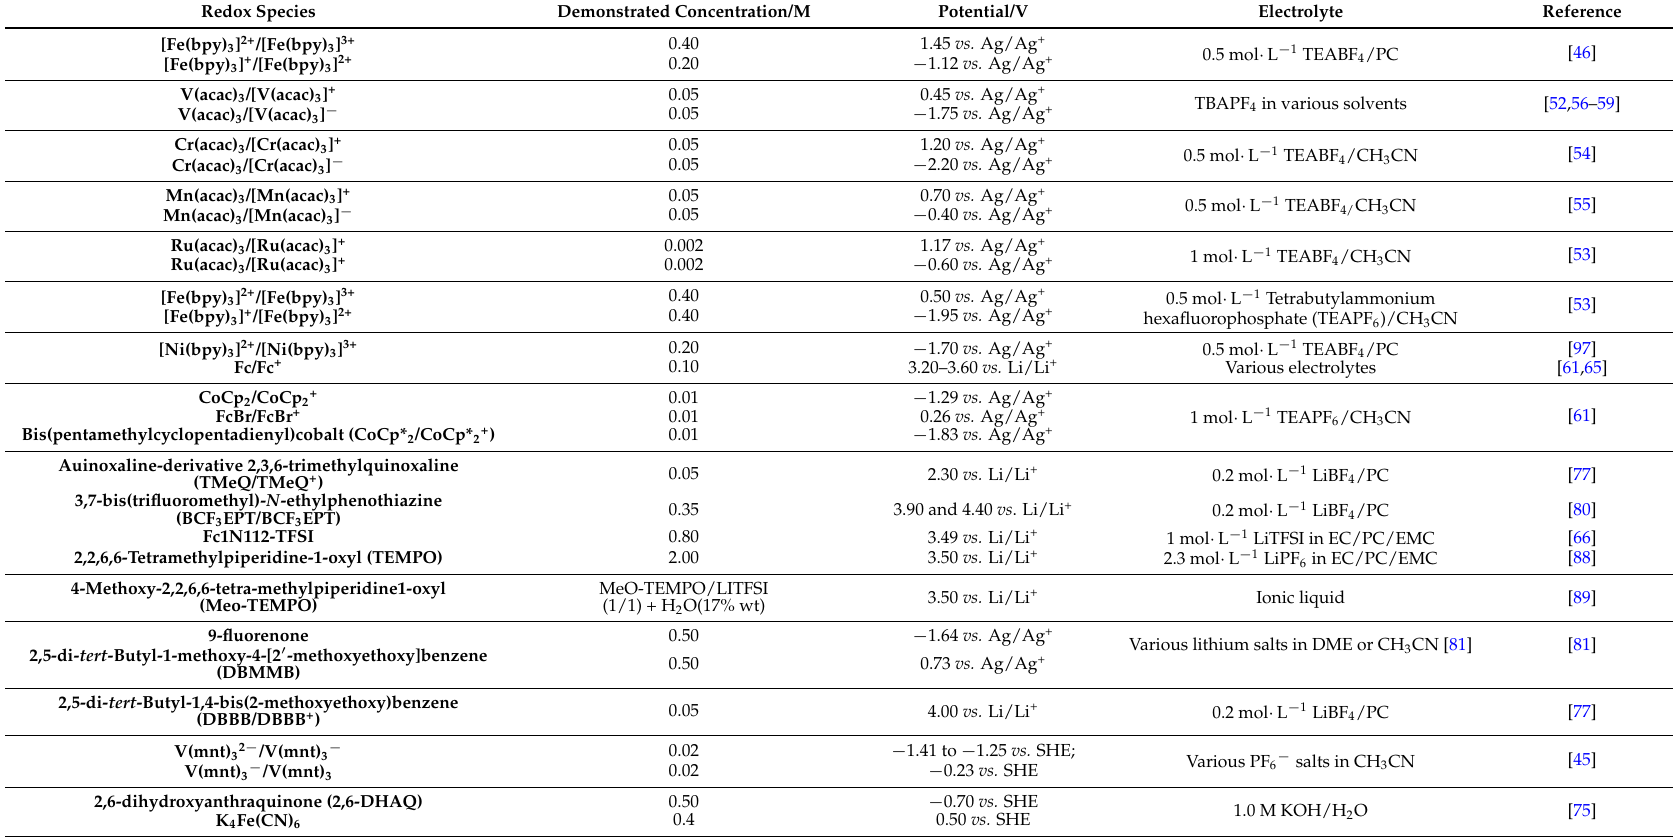
Table 2. Summary of metal complexes and metal-free organic compounds. acac, acetylacetonate; Fc1N112-TFSI, ferrocenylmethyl dimethyl ethyl